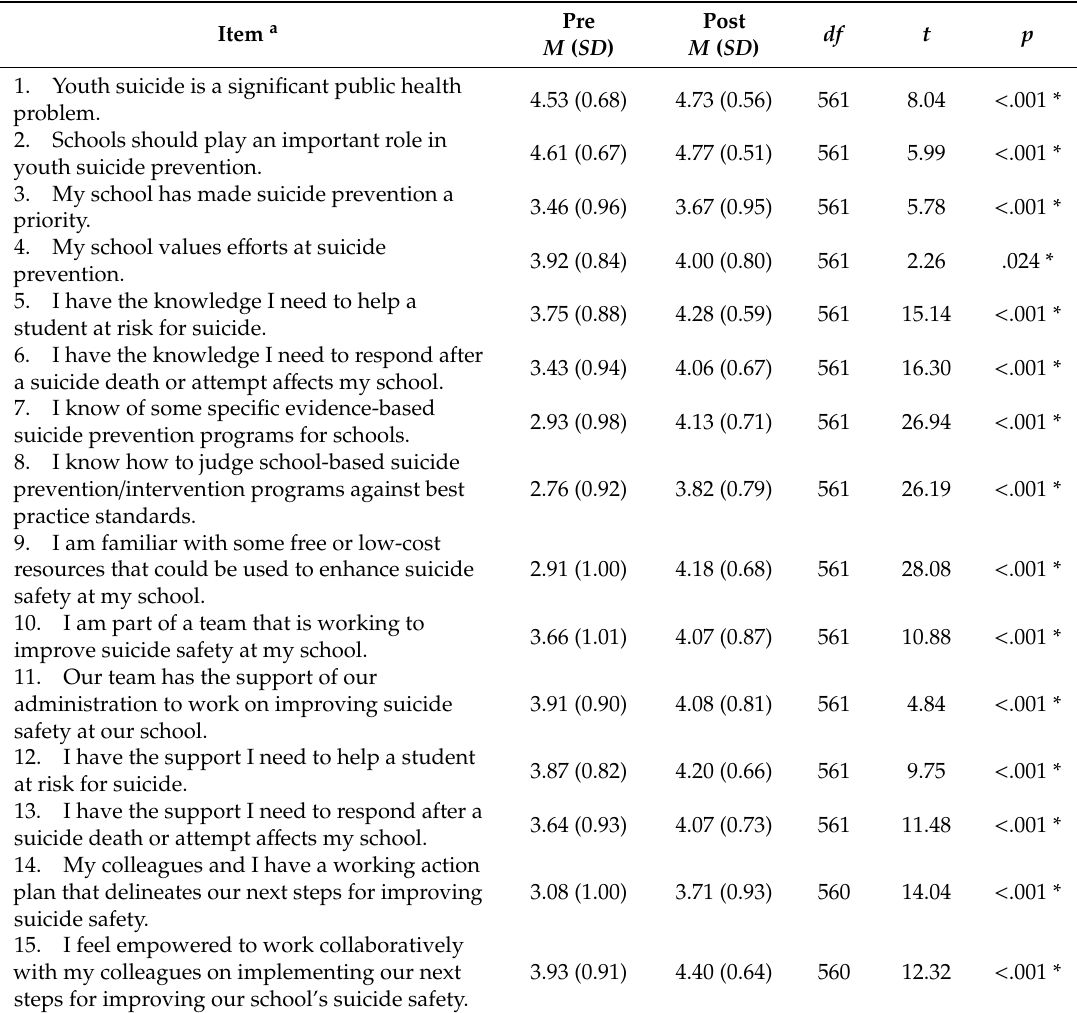
Table 1. CSSS workshop participants’ pre-test and post-test ratings of items related to suicide safety in the schools ( N =